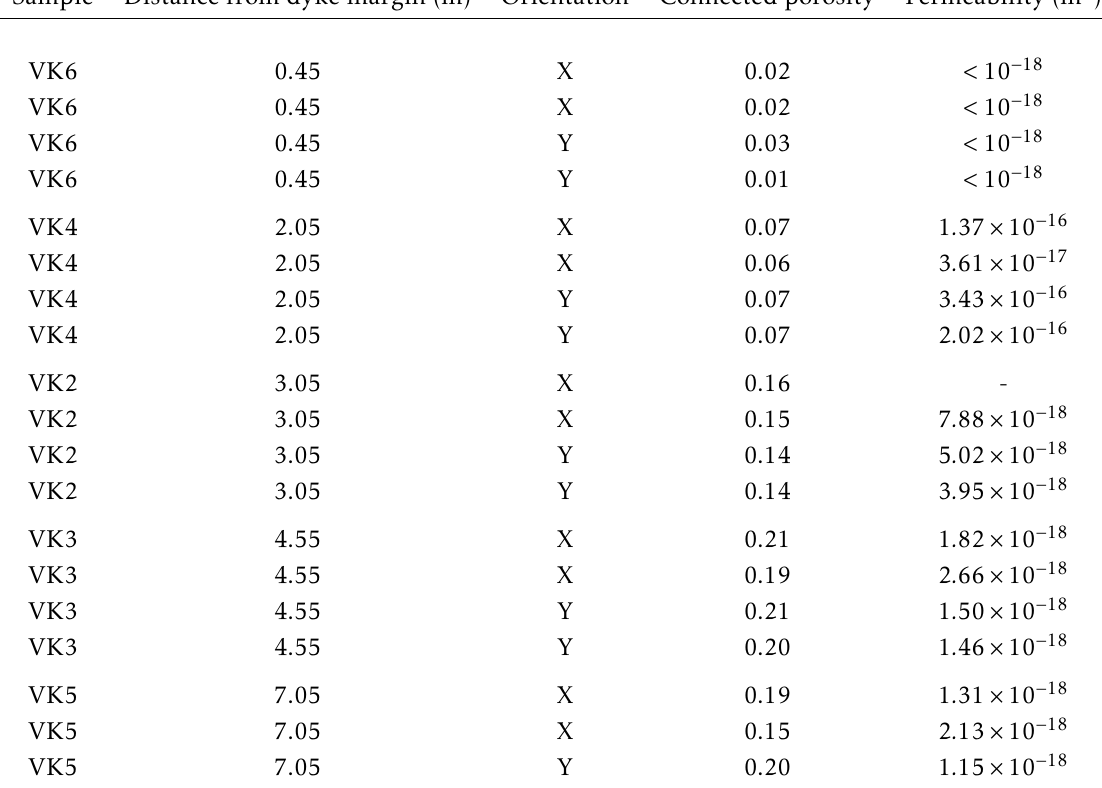
Table 3: Summary of the laboratory data (connected porosity and permeability) collected for this study. The experimental error on the measurements of porosity and permeability are (cid:28) 1 % and <1 %, respectively. Samples were either samples cored approximately perpendicular to dyke margin (X-direction) or approximately parallel to dyke margin